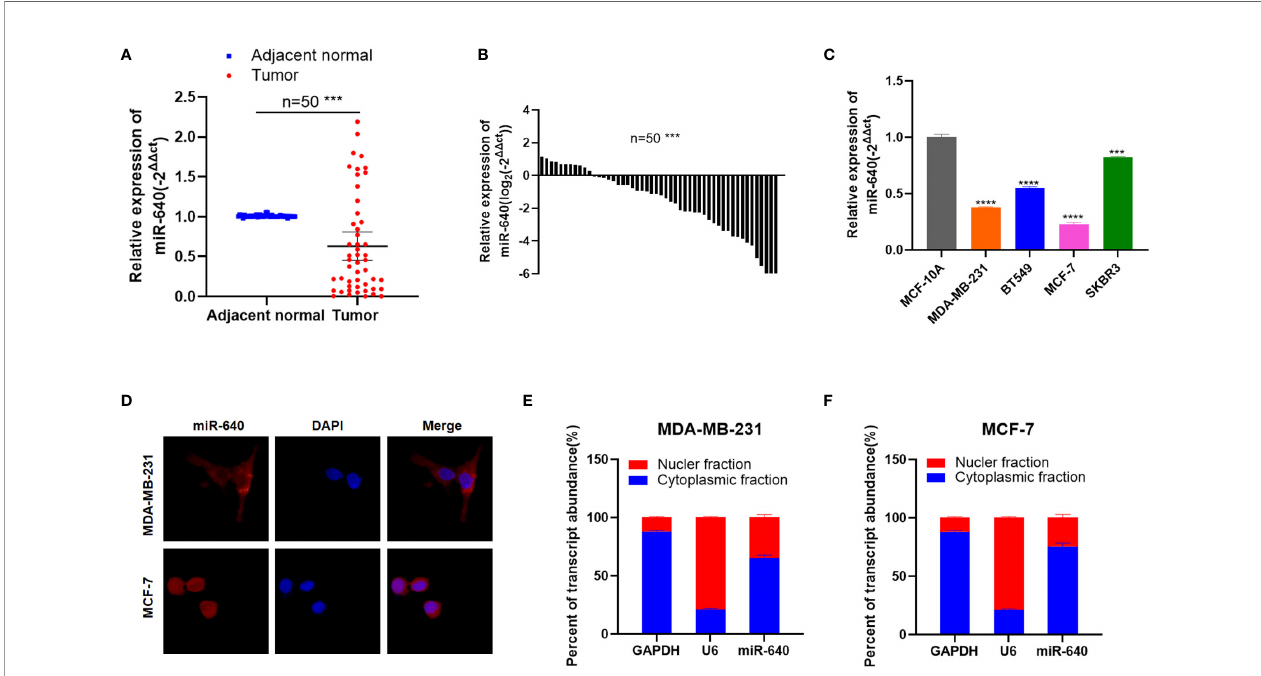
FIGURE 1 | MiR-640 was down-regulated in BC cell lines and tissues. (A, B) MiR-640 had low expression in BC tissues compared with adjacent normal tissues. (C) MiR-640 had low expression in BC cell lines. (D) Detection of colocalization of miR-640 in cytoplasm by FISH assay (magni fi cation, × 400). Red, miR-640; Blue,